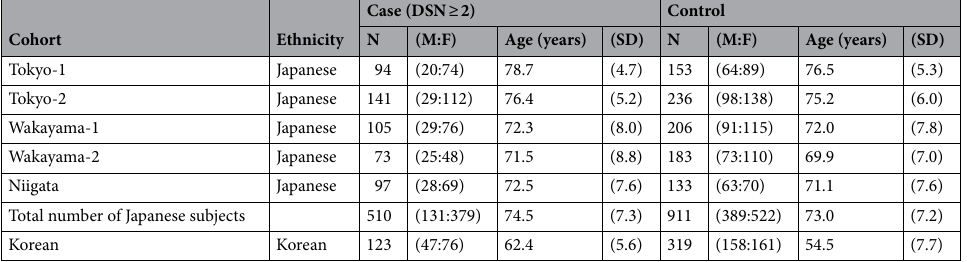
Table 1. Demographic data of each cohort. DSN disc space narrowing, M male, F female, SD standard deviation.